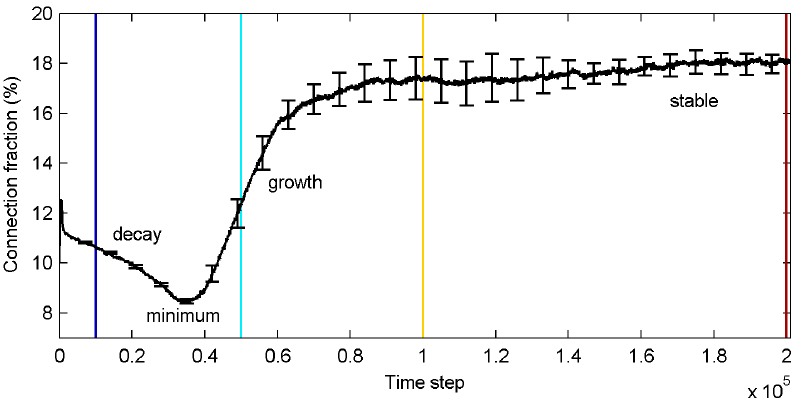
Figure 1. Average fraction of nonzero excitatory-to-excitatory connections as a function of time. The different phases of connectivity and time periods of investigation are indicated in terms of color. Errorbars represent standard errors (10 simulations) and are given every 7,000th time